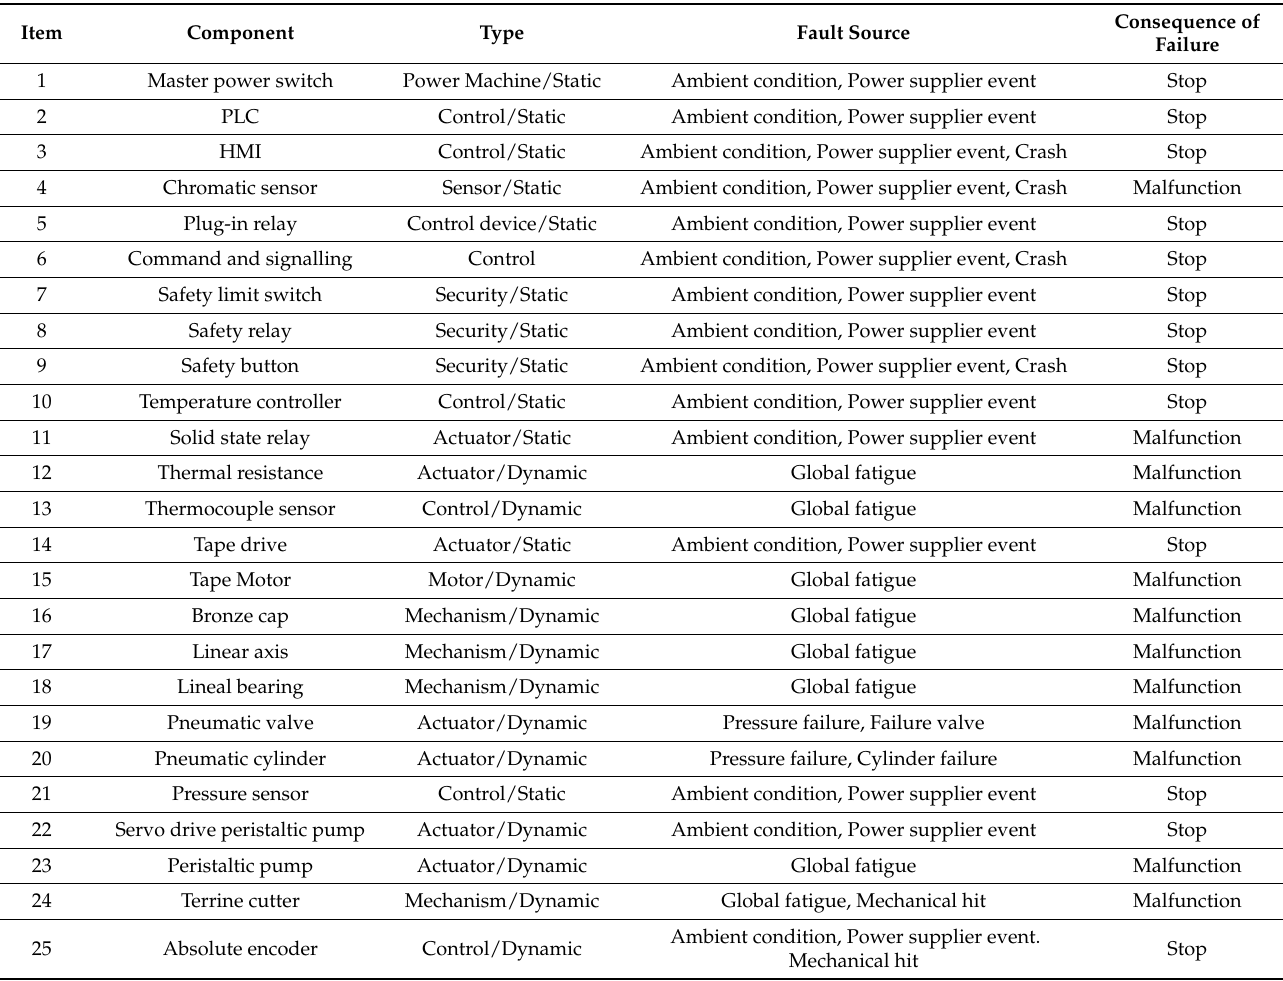
Table 1. Basic decomposition of components and faults in a multi-stage thermoforming